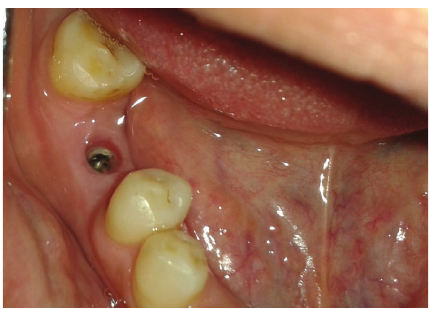
Figure 2: Implant with surrounding tissue.